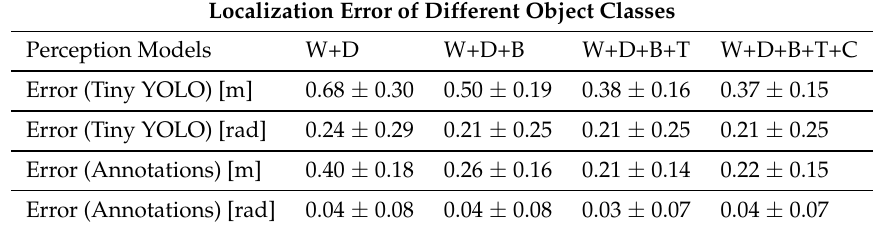
Table 2. Localization error of perception models using different object classes: W: windows, D: door, B: board, All: window, door, board, tables and chairs.